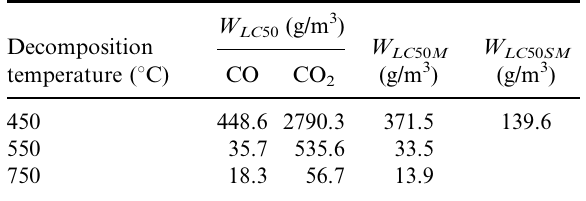
Table 9. Toxicometric indicators of modified polyester